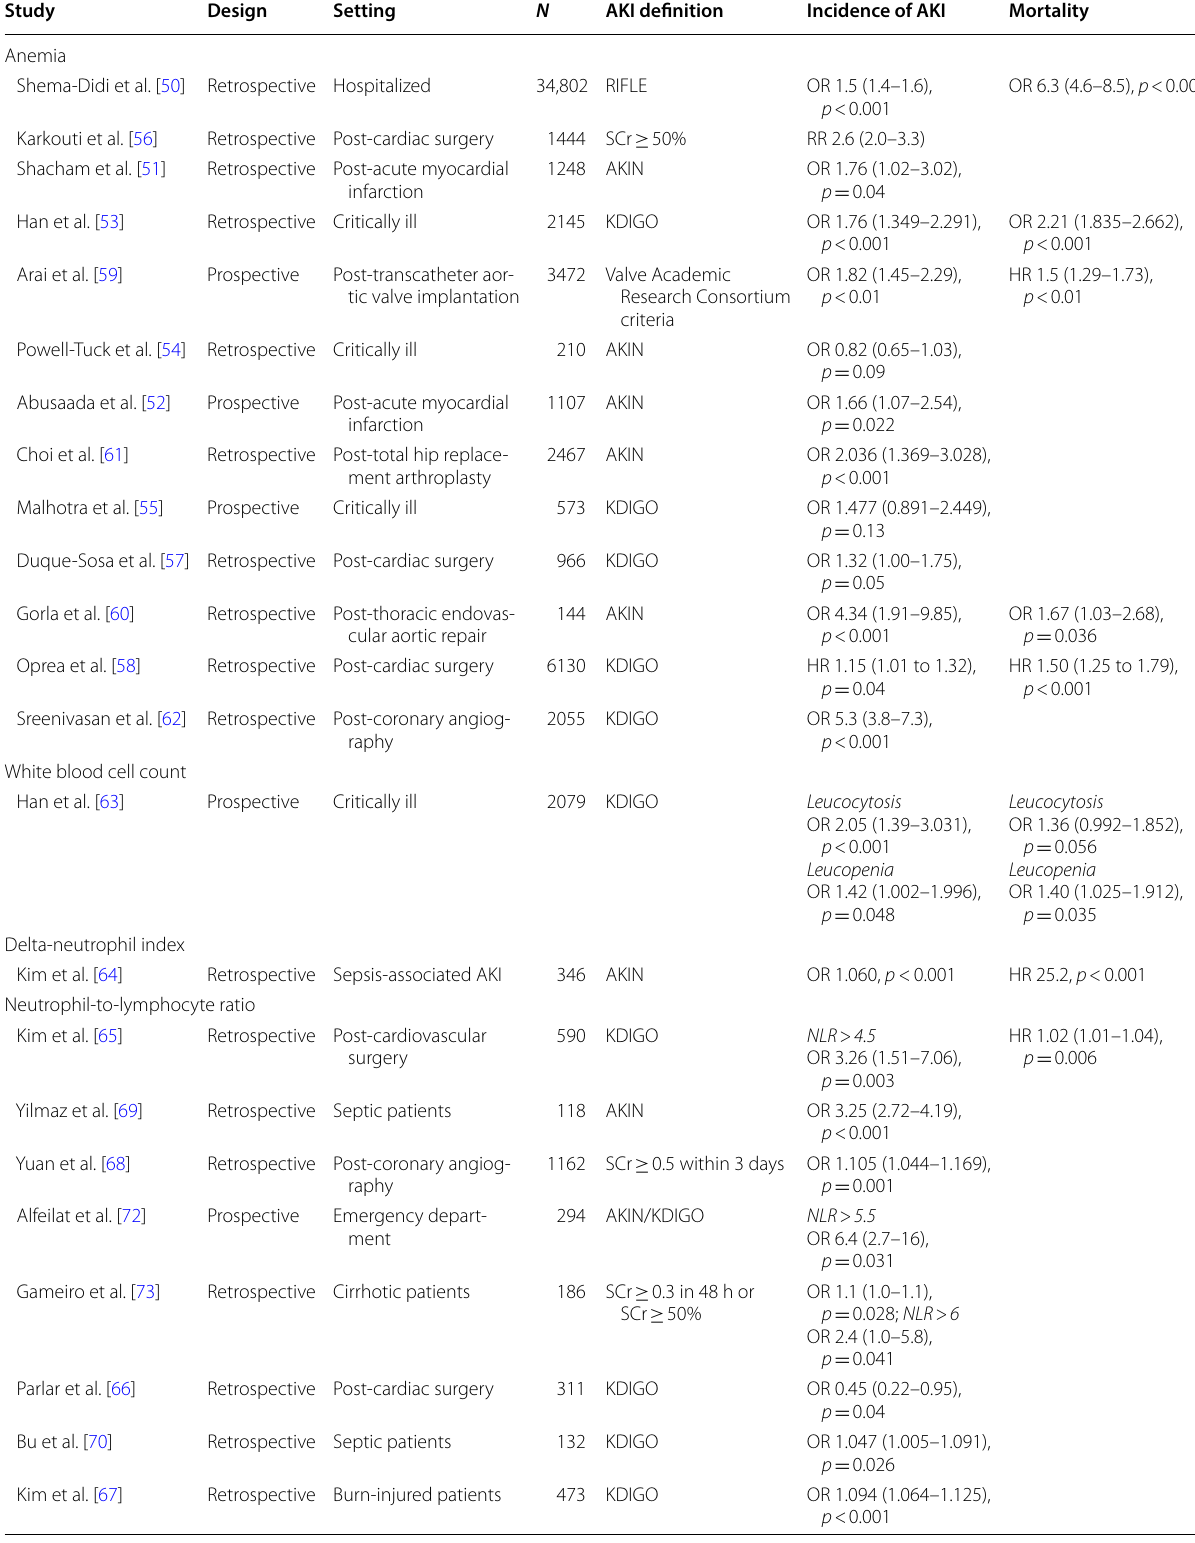
Table 3 Complete blood count parameters, AKI incidence, and